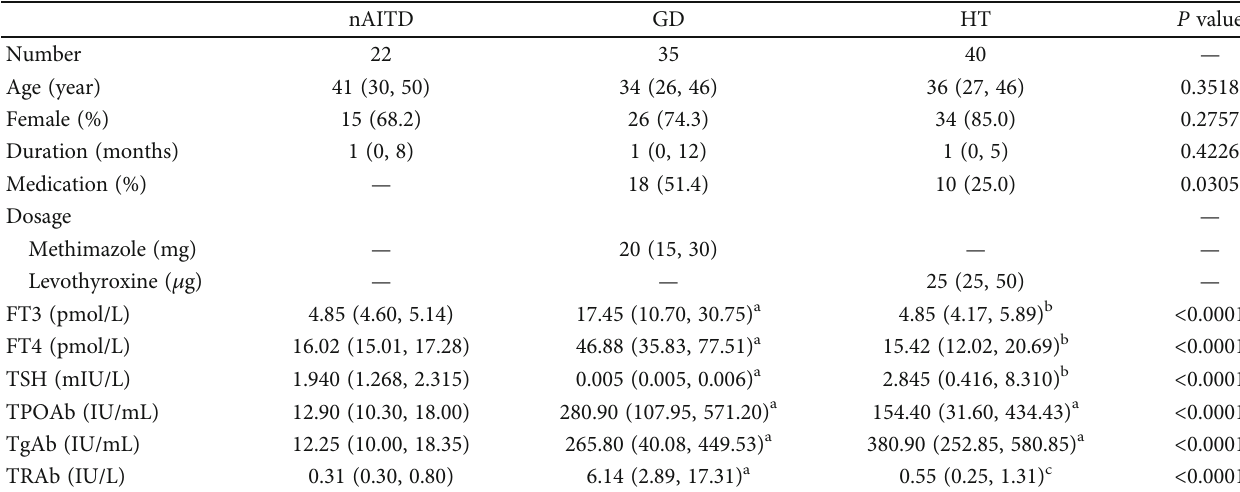
Table 2: Baseline characteristics of subjects with thyroid fi ne-needle aspiration